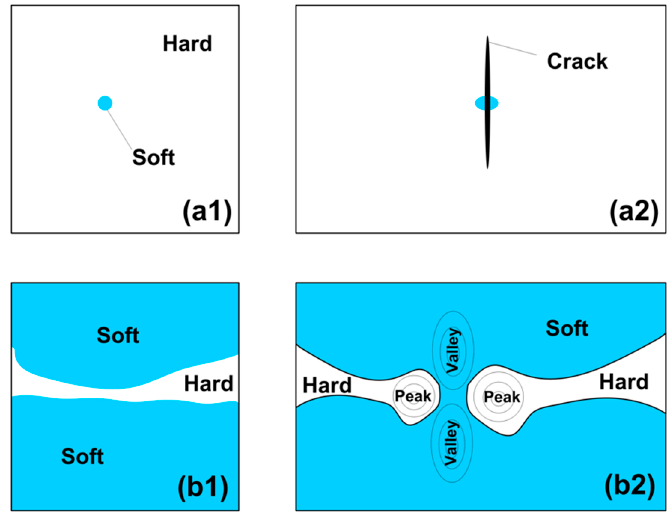
Figure 22. Formation of a short line crack ( a ) and a butterfly ( b ). Left (1): before stretching; right (2): after stretching.